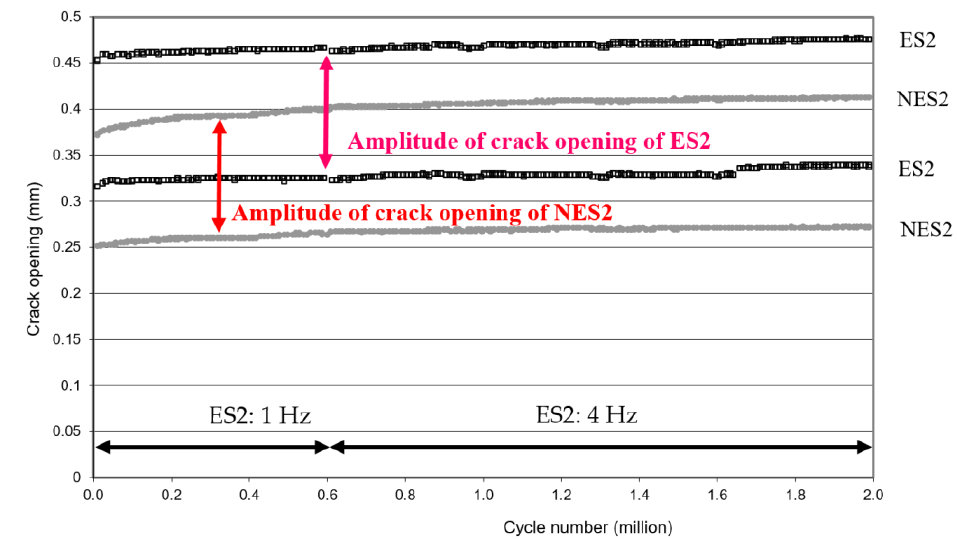
Figure 10. Evolution of crack opening extremes during fatigue tests of NES2 and ES2.